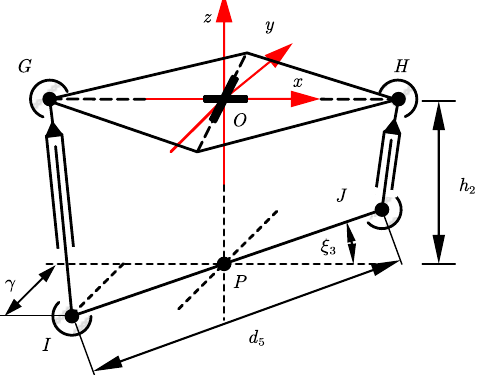
Figure 8. The schematic of yaw control. Rod GI and HJ indicate the trailing edge. Rod IJ indicates the servo